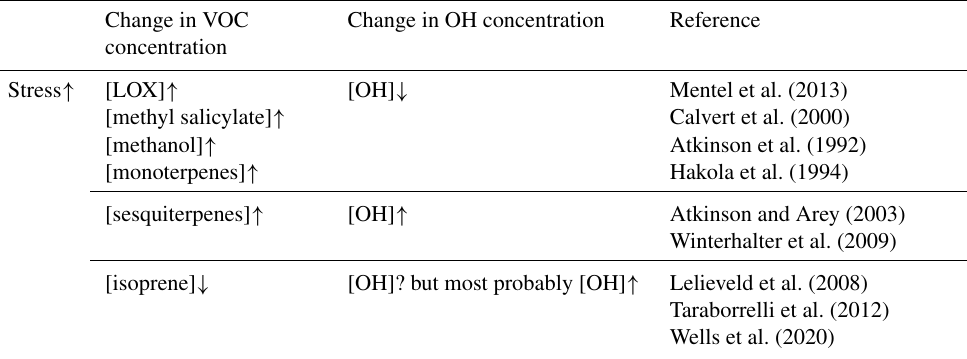
Table 3. Common changes in the atmospheric concentrations of volatile organic compounds (VOC) and OH during biotic plant stress. LOX are lipoxygenase pathway volatile compounds. Change in VOC